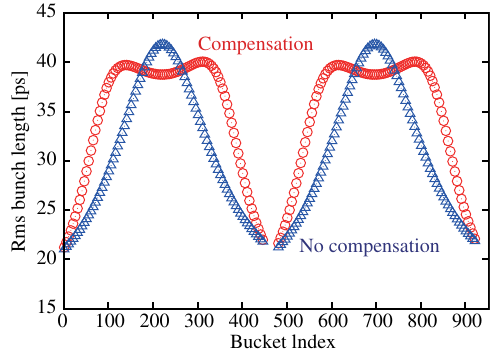
FIG. 9. Rms bunch lengths along the bunch trains with (circles) and without (triangles) the compensation. The bunch lengths are shown at every five buckets. The half bandwidth of the com- pensation was determined to be 1.1 MHz for both the main and harmonic cavities. We assumed a stored current of 500 mA, two 60-ns bunch gaps, and the parameters of the